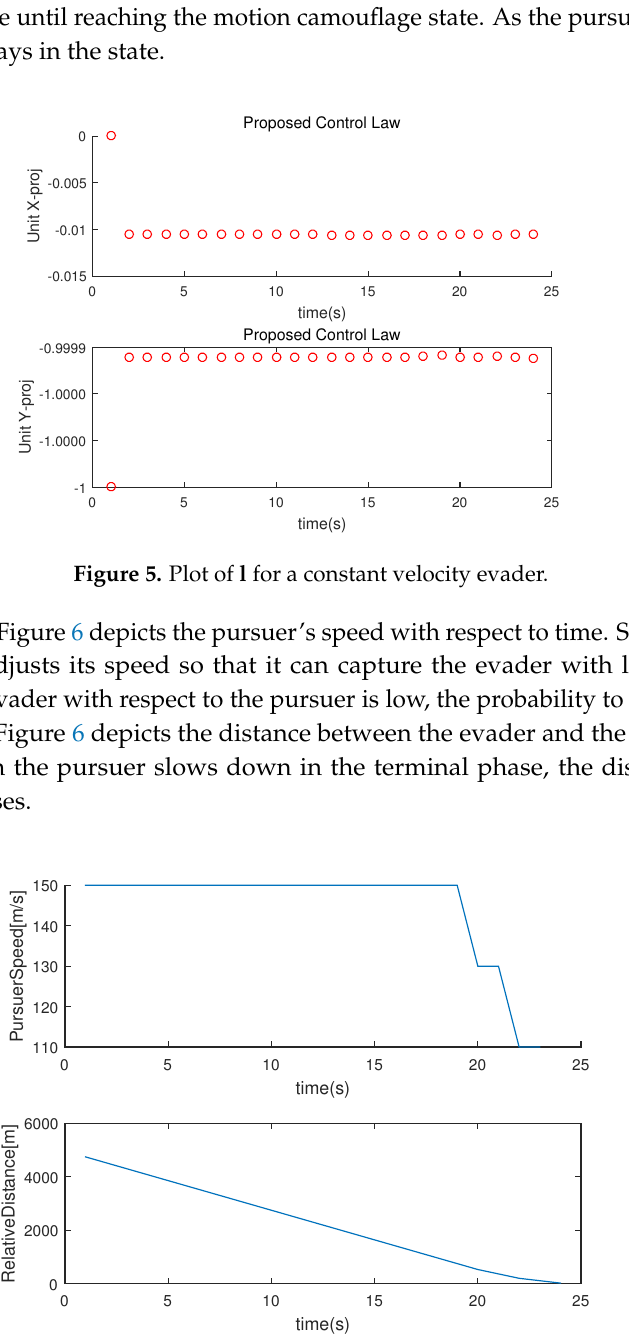
Figure 6. The ( top ) figure depicts the pursuer’s speed with respect to time. The ( bottom ) figure depicts the distance between the evader and the pursuer with respect to time (constant velocity